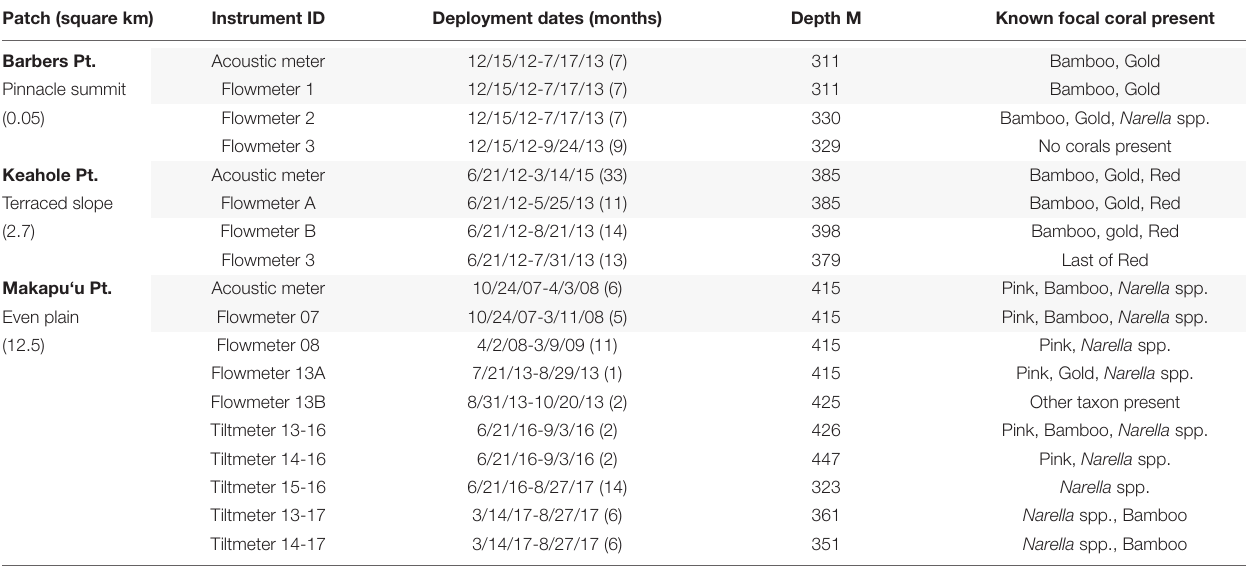
TABLE 1 | List of instruments types and deployment dates in the three coral patches indicating the area, depth, and the focal corals present. Patch (square